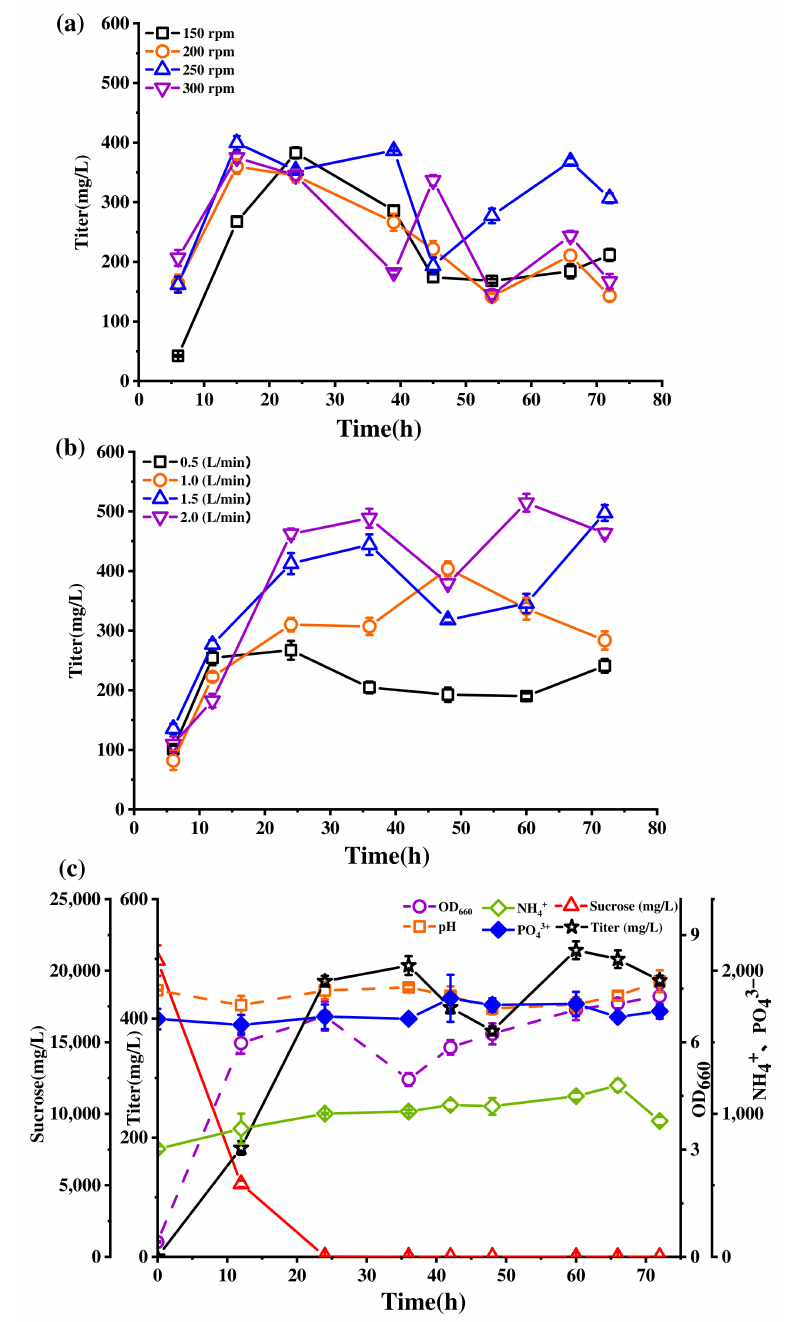
Figure 3. Optimization of stirring speed ( a ) and aeration rate ( b ) based on lichenysin production. ( c ) Analysis of the kinetic process of lichenysin